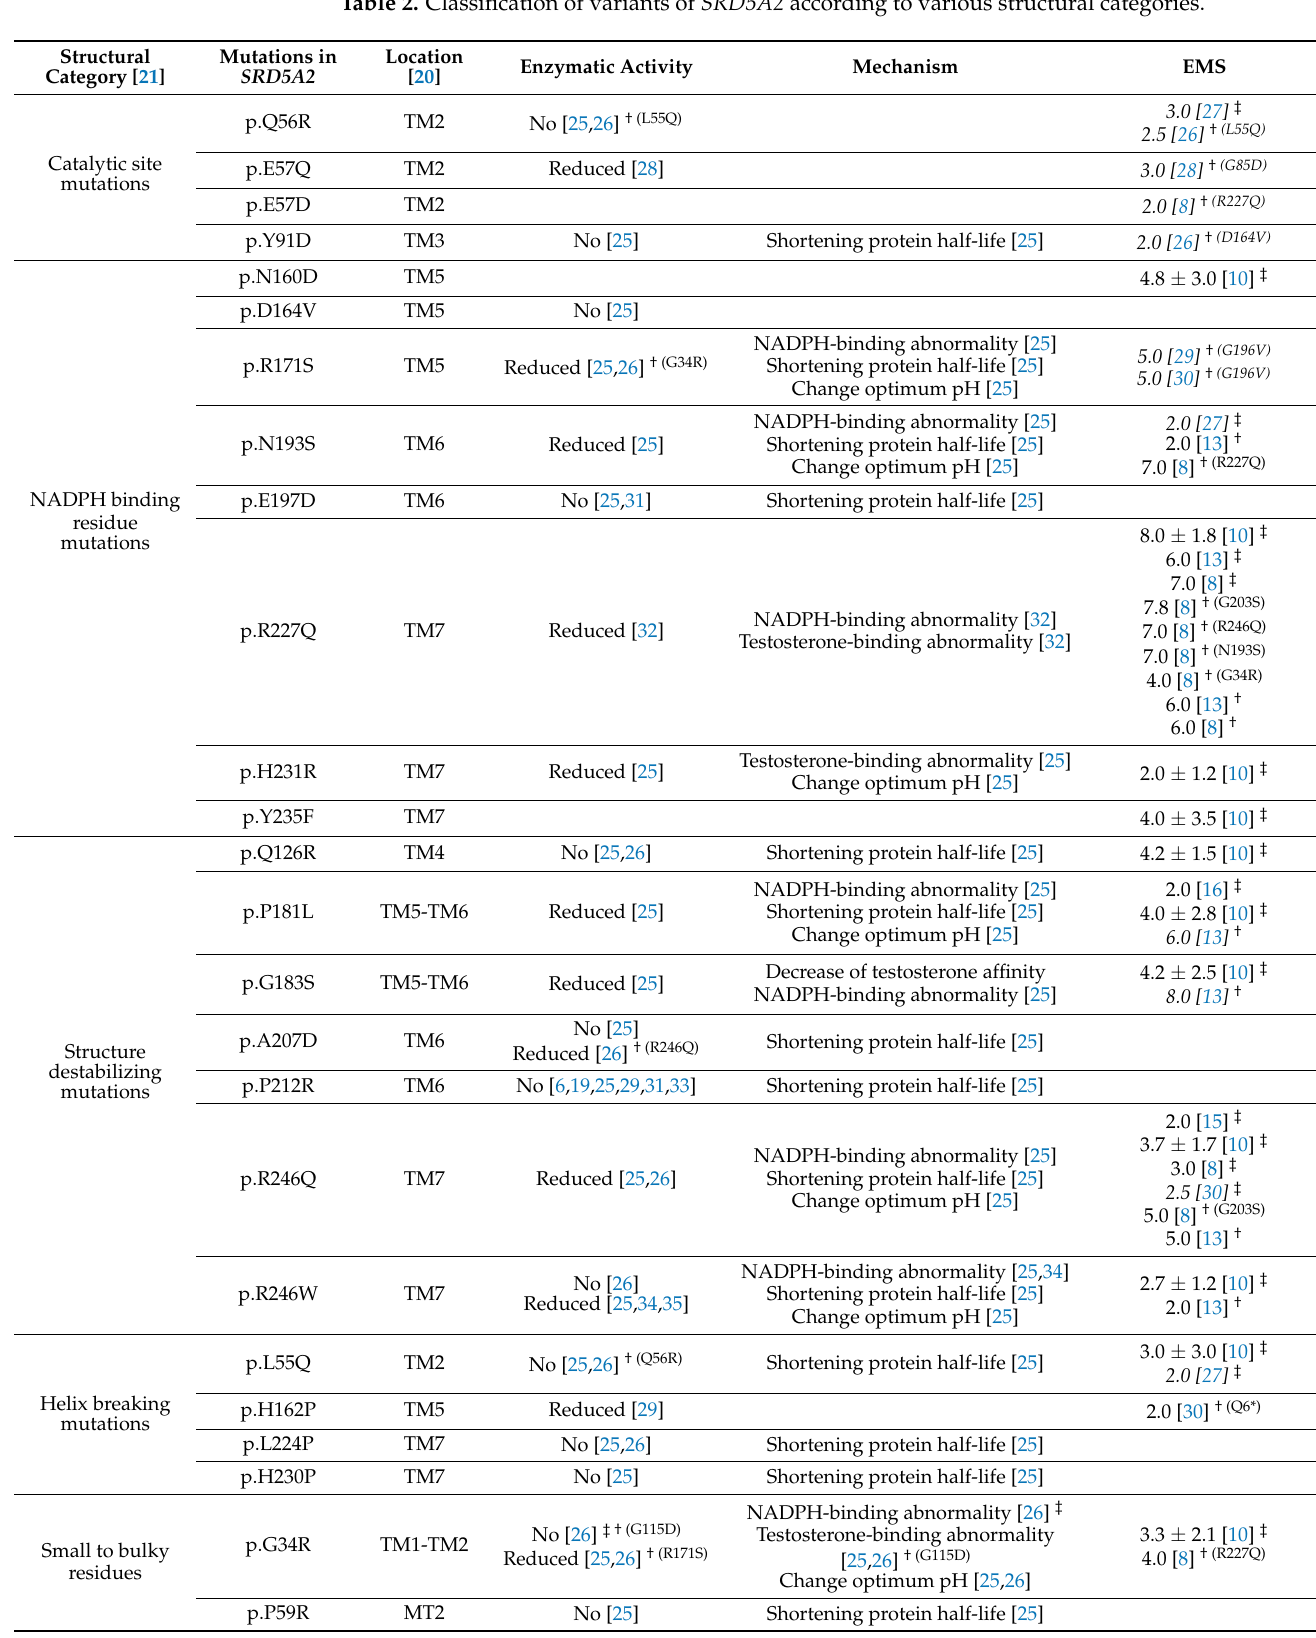
Table 2. Classification of variants of SRD5A2 according to various structural